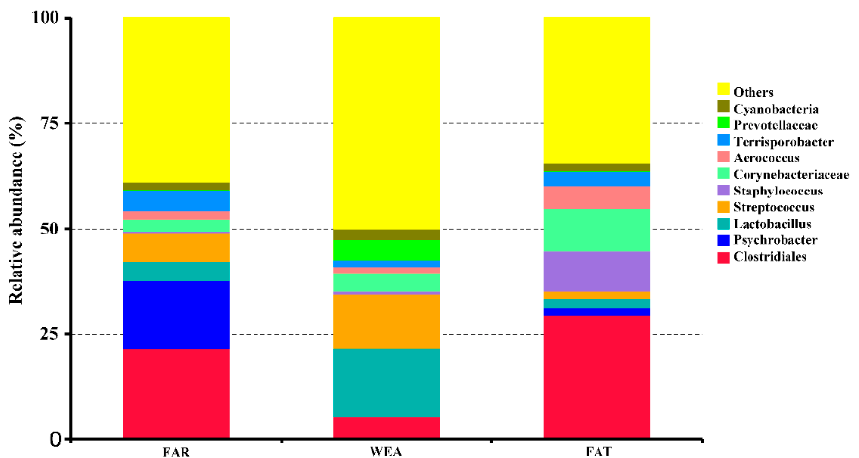
Figure 5. Relative abundances of the airborne bacterial genera (%).